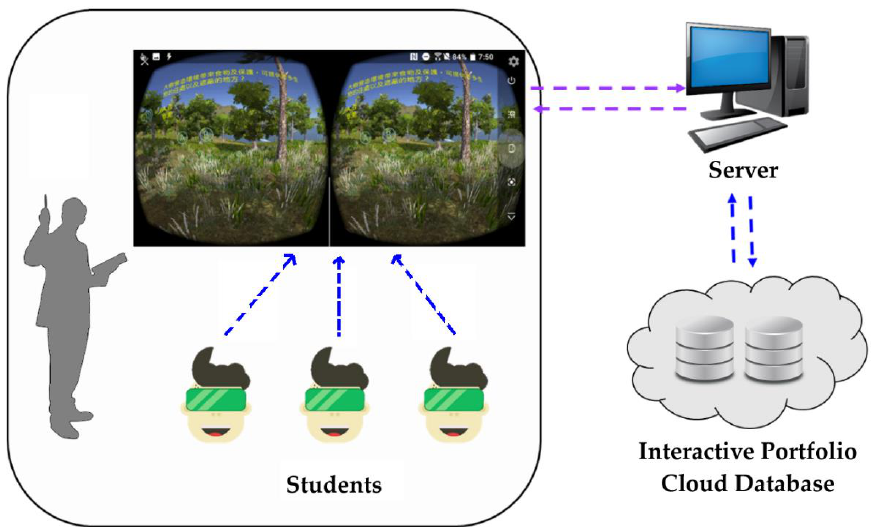
Figure 1. An experimental environment.